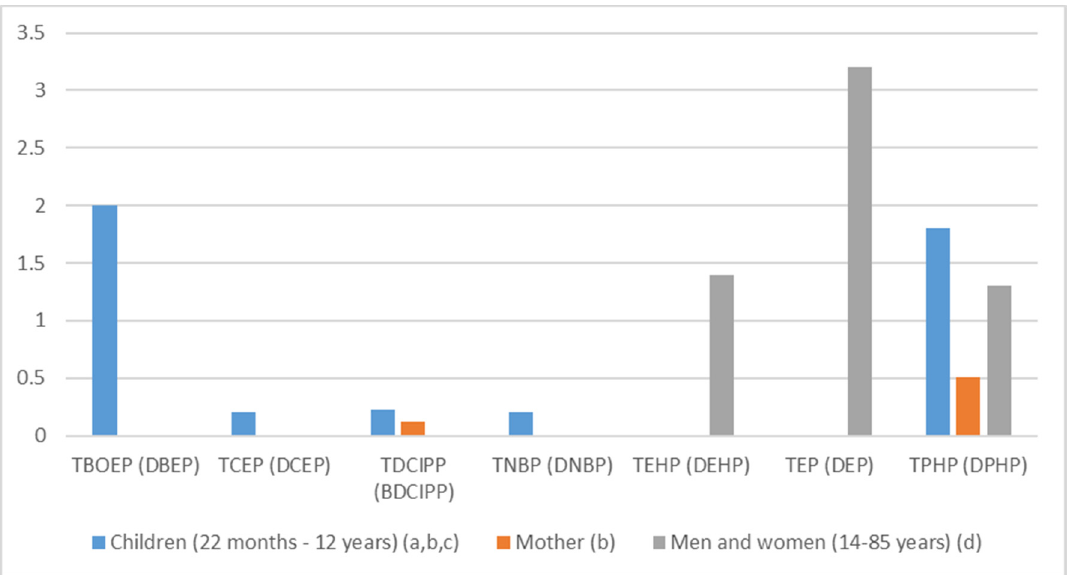
Figure 3. OPFRs (metabolite) highest median urinary concentrations (ng/L) in Europe, 2000–2018 (ng/mL); ( a ) Fromme et al., 2014 [21]; ( b ) Cequier et al., 2015 [27]; ( c ) Larsonn et al., 2014 [53]; ( d ) Reemtsma et al., 2011 [54].